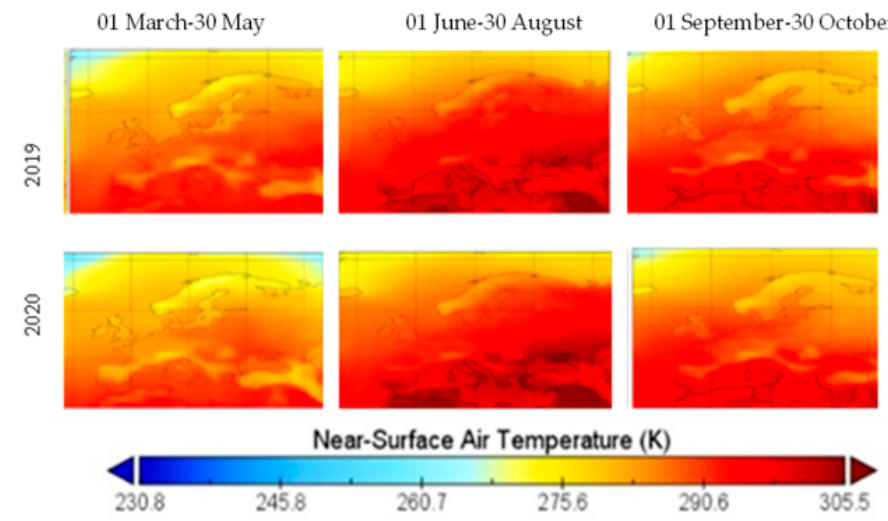
Figure 7. Mean of near-surface air temperature over Europe in three periods, 2019 and 2020.